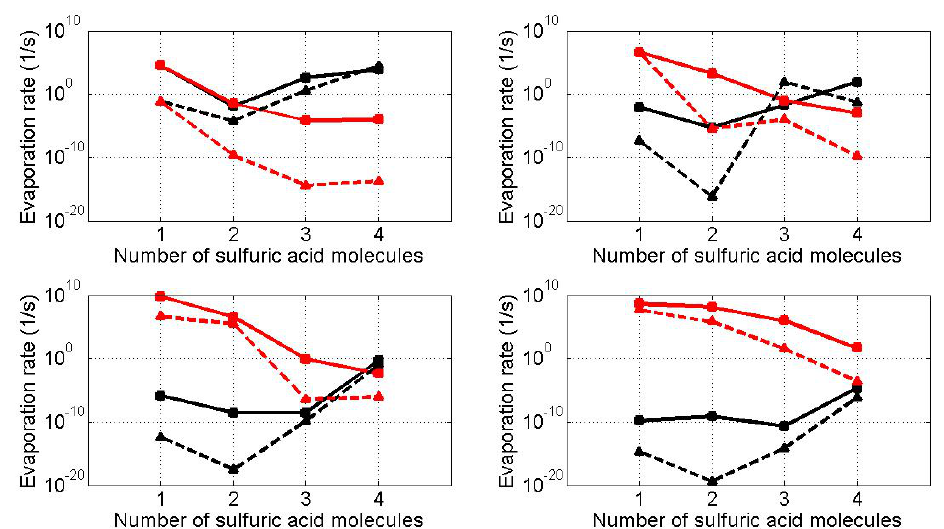
Fig. 2. Evaporation rates of acid (black lines) and base molecules (red lines) from ammonia (solid lines) and DMA (dashed lines) containing clusters. The top left, top right, bottom left, and bottom right panels give the results for 1, 2, 3, and 4 base containing clusters,